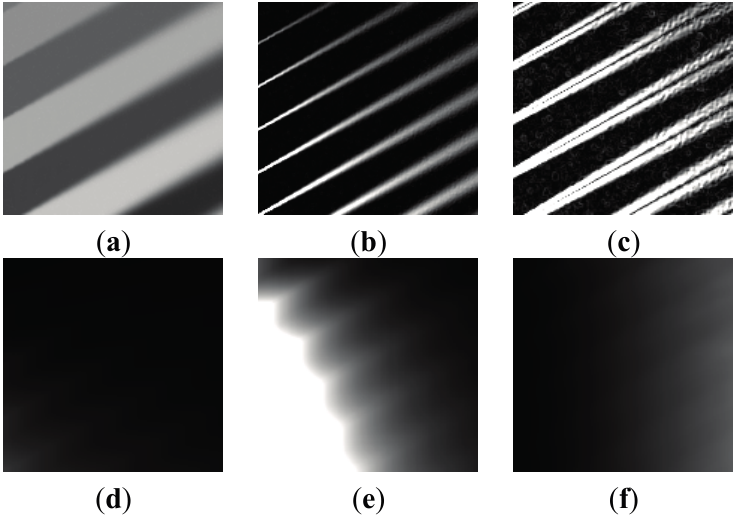
Figure 6. Computational procedure for estimating the blur component ( , ) B x y : ( a ) a synthetically degraded image by spatially varying blur; ( b ) the derivative of (a); ( c ) the second-order derivative of (a); ( d ) the local variance of (b); ( e ) the local variance of (c); and ( f ) the estimated blur component ( , ) B x y